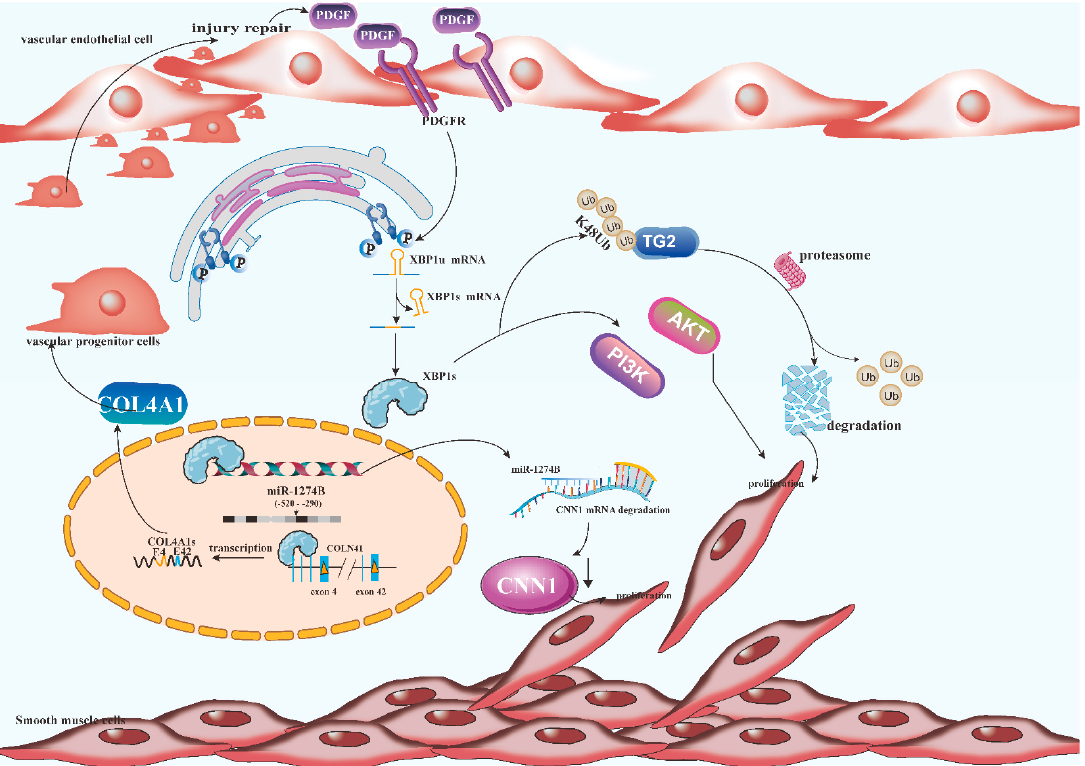
Figure 3. Schematic representation of the critical molecular mechanism by which XBP1s regulates smooth muscle cells proliferation and neointima formation in smooth muscle cells. PDGF may be released in areas of injury caused by vascular injury. The released PDGF binds to PDGFR on smooth muscle cells, causing PDGFR to interact with IRE1 and activate phosphorylation of IRE1 and splicing of XBP1 mRNA. XBP1s directly linked to the region 520 to 290 of the mir-1274B promoter, activated miR-1274B transcription, targeted and degraded CNN1 mRNA, resulting in decreased CNN1 protein and decreased SMC proliferation. The XBP1s protein directs the transcription of COL4A1 gene by binding to the enhancer in exons 4 and 42 of COL4A1 gene. COL4A1s acts as a paracrine cytokine to mobilize vascular progenitor cells (VPCs) to the site of injury, thereby promoting wound healing or disease improvement. TG2 induces β -catenin and PDGF signaling in VSMCs, which in turn enhances the proliferation, migration, and phenotypic switching ability of these cells. Cells lacking XBP1s can increase the proteasomal breakdown of TG2 by promoting K48 polyubiquitination. PDGF: Platelet-derived growth factor, CNN1: calponin h1, COL4A1: type IV collagen alpha 1. TG2: Transglutaminase